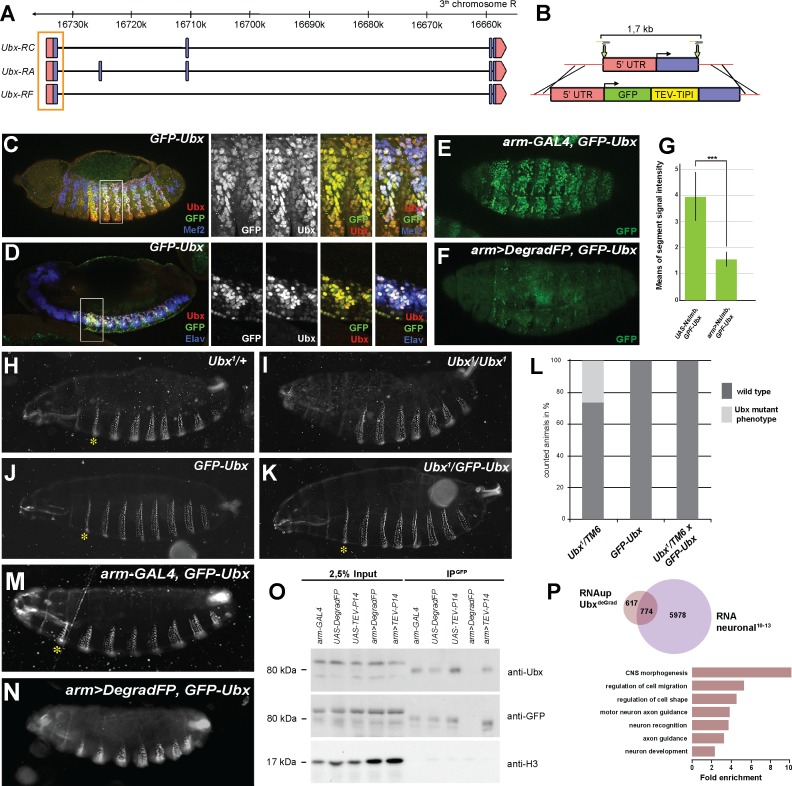
Generation and validation of CRIPR/Cas9 generated GFP-Ubx flies.(A) Genomic region of Ubx gene, exons are illustrated in boxes (red: non-coding regions, blue: coding regions) and introns in lines, orange box highlights the 1st exon. (B) close up of the 1st exon targeted by guide RNAs (green arrows) for CRISPR/Cas9, below: construct used for homologous recombination, recombination event illustrated by the crossed lines. Red: non-coding region, blue: coding region, green: GFP coding region, yellow: spacer containing a TEV cleavage site with TIPI-degron (TEV protease- induced protein inactivation) (C, D) Lateral view of stage 14 GFP-Ubx Drosophila embryos stained for the muscle differentiation marker Mef2 (blue) (C), the pan-neuronal marker Elav (blue) (D), Ubx (red) and GFP green). Boxes indicate the location of the close-ups on the right panel. (E, F) Lateral view of stage 15 arm-GAL4,GFP-Ubx and arm >Nslmb,GFP-Ubx Drosophila embryos stained for GFP (green) to highlight Ubx expression. The GFP staining is mostly lost in the ectoderm, mesoderm and neuronal system when Ubx is degraded (F) as compared to the control (E). (G) Quantification of GFP signal intensity in the whole arm-GAL4,GFP-Ubx and arm >Nslmb,GFP-Ubx Drosophila embryos, showing that GFP is strongly decreased (***=p < 0.001). (H–K) Lateral view of first instar larva cuticles, heterozygous (H) and homozygous Ubx mutants (I), homozygous GFP-Ubx (J), heterozygous Ubx mutant over GFP-Ubx (K), asterisk indicates the 1st abdominal segment (A1), homozygous Ubx mutants show a loss of the denticle belts in A1 compared to the heterozygous control and the GFP-Ubx line, the Ubx mutant phenotype can be rescued with the GFP-Ubx. (L) Quantification of the rescue experiment, showing that no Ubx phenotype is detachable in the Ubx1/TM6 with GFP-Ubx cross, indicating that GFP-Ubx is fully functional during embryonic and larval development. (M, N) Lateral view of first instar larva cuticles, arm-GAL4,GFP-Ubx (M) and arm >Nslmb,GFP-Ubx (N), asterisk indicates A1, arm >Nslmb,GFP-Ubx larvae (N) shows a loss of the A1 denticle similar to the homozygous Ubx mutant (I) when compared to arm-GAL4,GFP-Ubx (M). (O) GFP protein immunoprecipitation (IP) experiments in Drosophila embryos, comparison of GFP-nanobody (deGrad) and TEV-TIPI protein degradation efficiency, control lines: arm-GAL4,GFP-Ubx (arm-GAL4), UAS-Nslmb,GFP-Ubx (UAS-Nslmb), UAS-TEV-P14;GFP-Ubx (UAS-TEV-P14), crosses: arm-GAL4,GFP-Ubx x UAS-Nslmb,GFP-Ubx (arm >Nslmb), arm-GAL4,GFP-Ubx x UAS-TEV-P14;GFP-Ubx (arm >TEV P14), expected size of GFP-Ubx 80 kDa, IPs are probed with antibodies indicated on the right, lane 1–5 are 2.5% input of each sample, lane 6–10 GFP-trap bead IP-experiments for each sample, control samples indicate bands for GFP-Ubx using GFP or Ubx antibodies, arm >Nslmb shows no band for GFP-Ubx, whereas arm >TEV P14 displays the same band as the control samples, indicating that the degradation of the GFP-Ubx with GFP-nanobody technology is more efficient than with the TEV-TIPI system. (P) Upper panel: Venn diagram representing the overlap between the neuronal stage 10–13 transcriptome (purple) and the genes up-regulated in mesodermal nuclei after Ubx depletion (RNAup UbxDeGrad) (pink). Lower panel: Fold enrichment of gene ontology terms of the 578 genes expressed in neuronal cells and up-regulated in mesodermal cells after Ubx depletion.